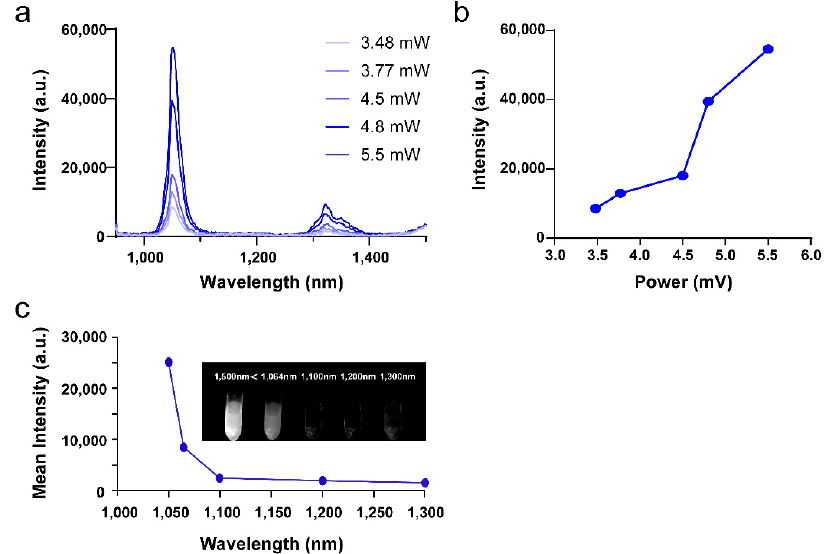
Figure 3. Optical properties of CaF 2 :Y,Gd,Nd NPs. ( a ) The emission spectra of CaF 2 :Y,Gd,Nd NPs with different laser powers (excited by an 808 nm laser); ( b ) the emission intensities of CaF 2 :Y,Gd,Nd NPs (at 1050 nm) with different laser powers under 808 nm laser excitation; ( c ) in vitro NIR-II emission intensity of CaF 2 :Y,Gd,Nd NPs (2 mg/mL) at different wavelengths (excited by an 808 nm laser, 50 mW/cm 2 ); inset shows the NIR-II image of CaF 2 :Y,Gd,Nd NPs versus 808 nm excitation.